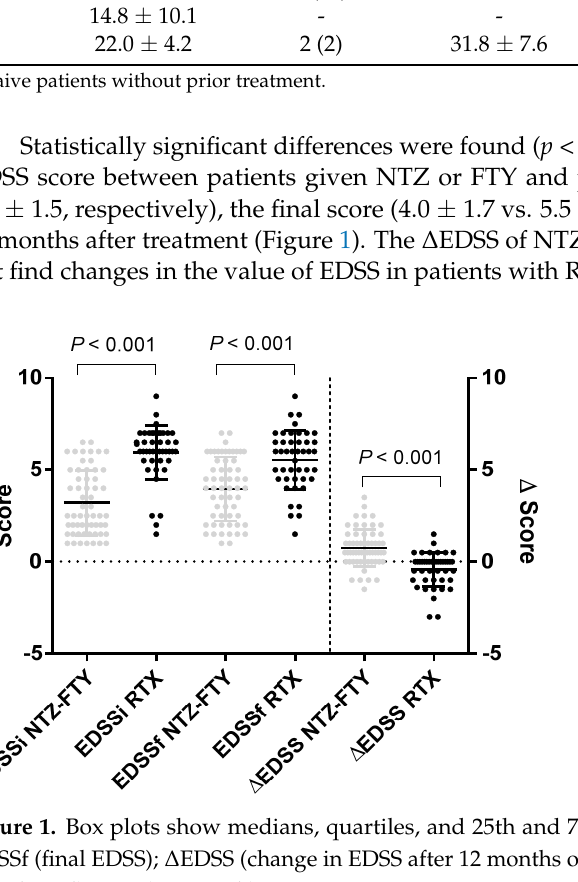
Figure 2. Cox regression model for relapses with Δ Time.